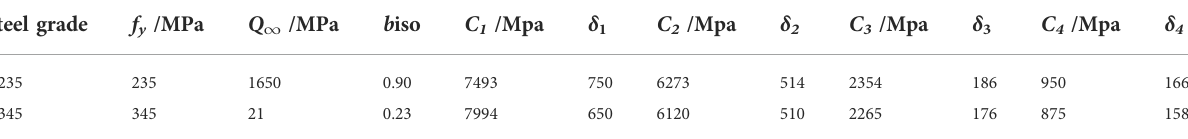
TABLE 5 Parameters of the cyclic constitutive models. Steel